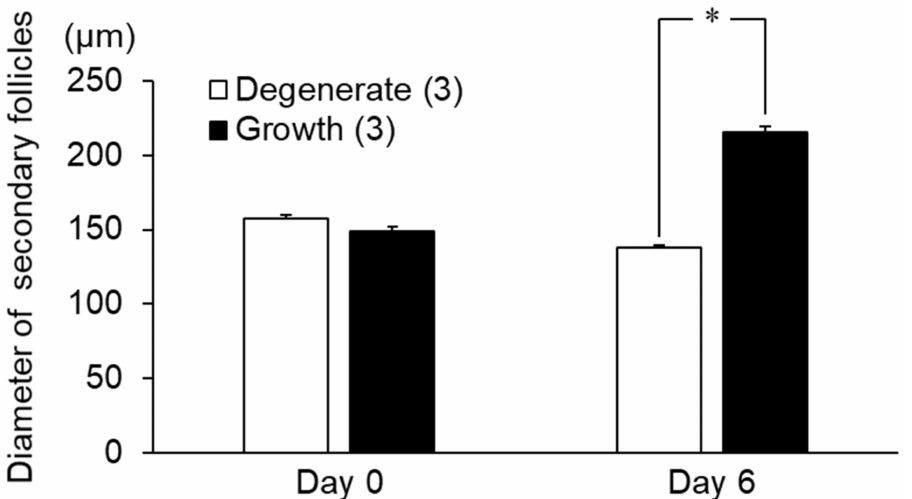
Figure 7. The diameter of secondary follicles was selected for the free amino acid analysis as the growth and degenerate groups before and after secondary follicle culture. * An asterisk indicates a significant difference between the growth and degenerate groups ( p < 0.05). Numbers in parentheses indicate the number of follicles in each